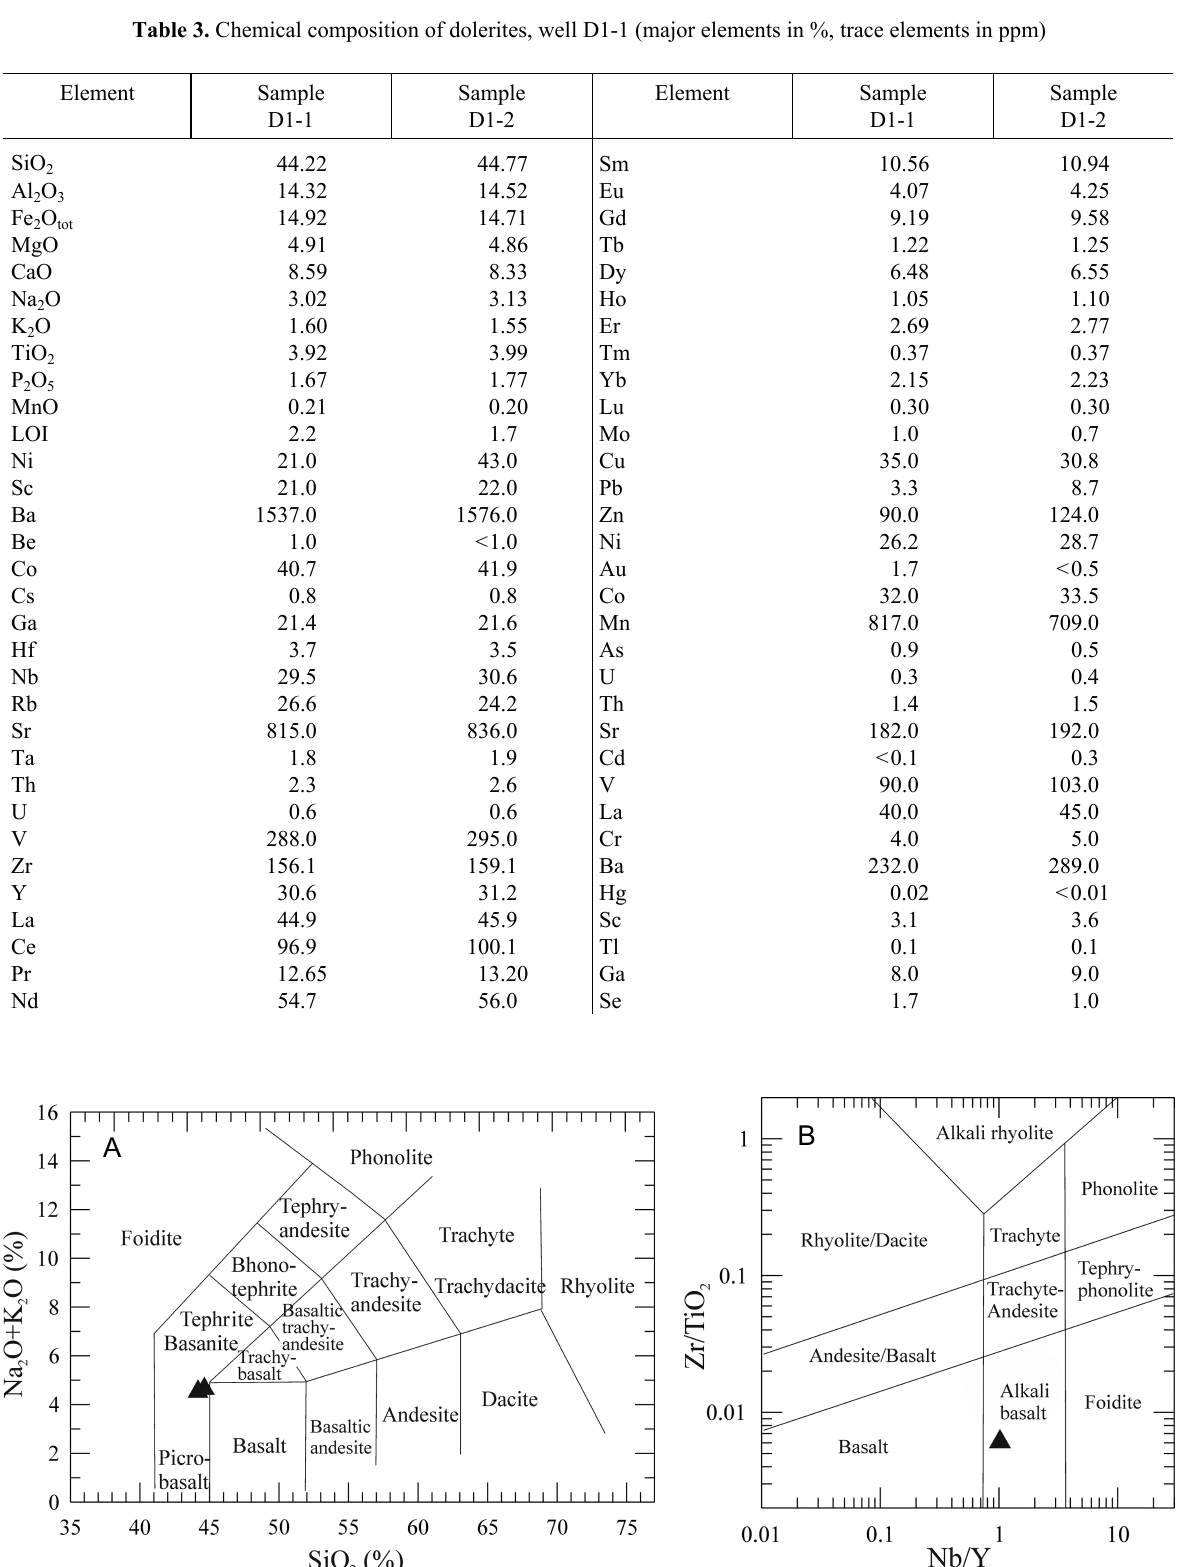
Fig. 6. Classification diagrams for dolerite from well D1-1: A , total alkali vs silica; B , Zr/TiO 2 vs Nb/Y of Winchester & Floyd